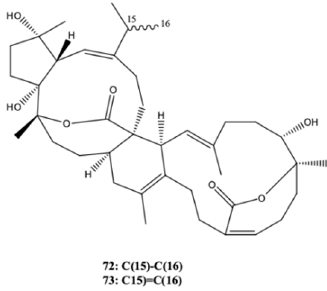
Figure 8. Biscembranoid-like compounds, bissubvilides A ( 72 ) and B ( 73 ) from the soft coral Sarcophyton subviride